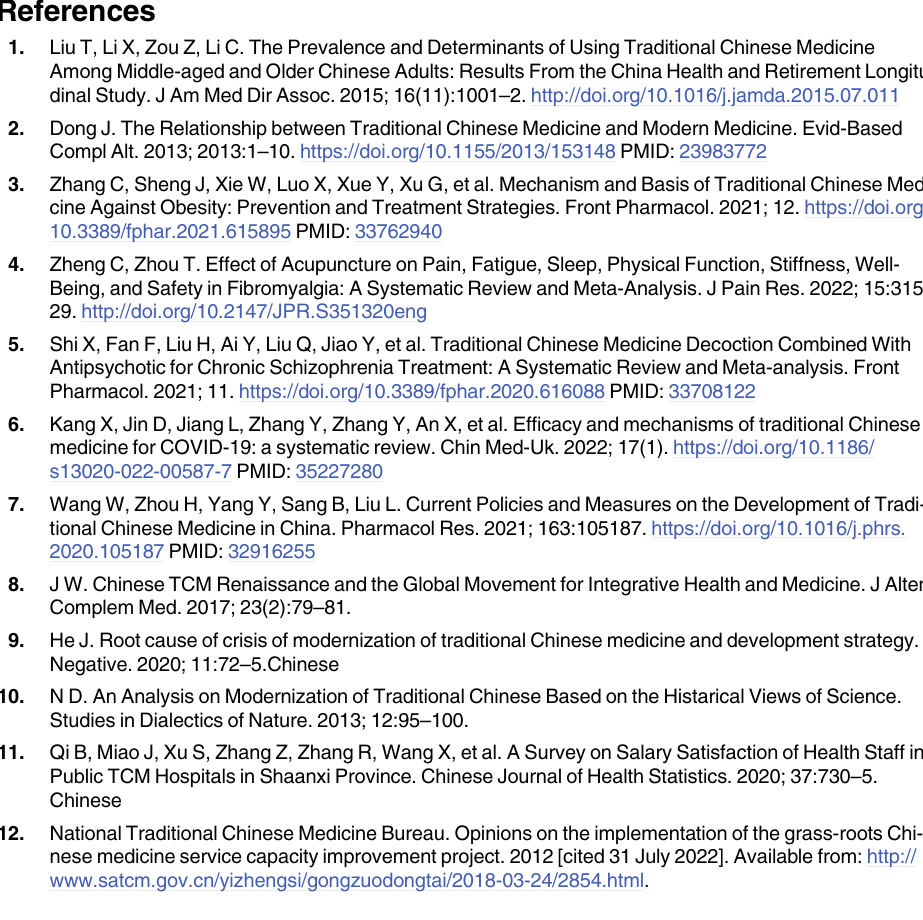
S1 Table. The level and incrementation of TCM health resources per 1000 person in differ- ent provinces. S2 Table. The agglomeration degree of TCM health resources in different province